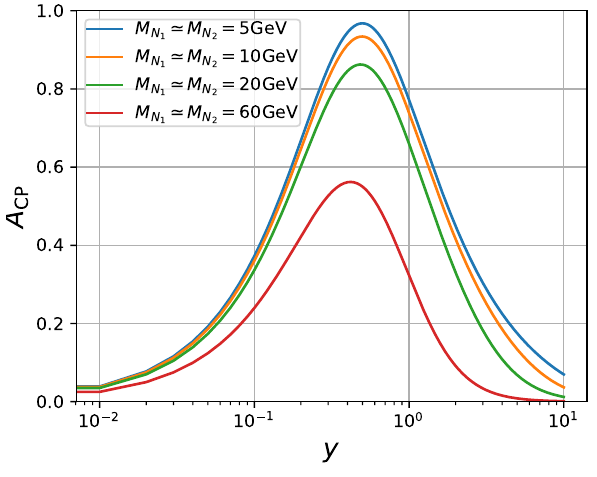
Figure 2 . Value of A CP as a function of y , for δφ = π/ 2 and for various values of M N . For negative values of y , A CP → − A CP